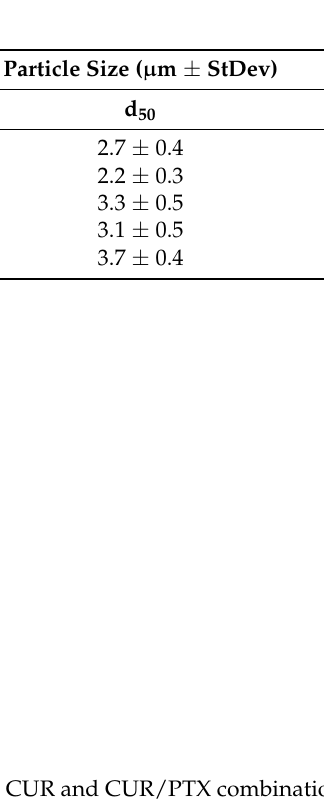
Table 1. Particle size distribution of milled formulations of CUR, PTX and CUR/PTX. CUR: curcumin;